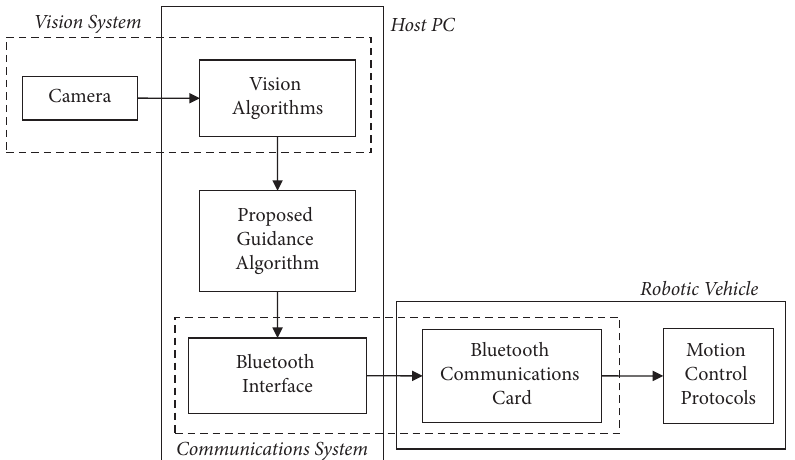
Figure 9: Experimental setup: software process fow diagram.